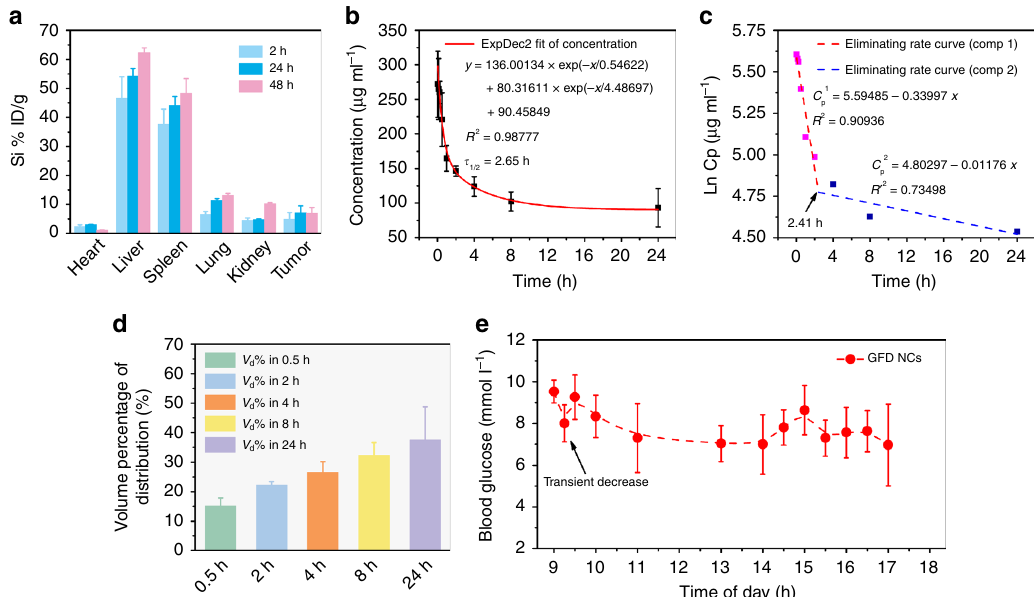
Fig. 6 Pharmacokinetics and pathoglycemia studies of GFD NCs. a The biodistribution of Si (% injected dose (ID) of Si per gram of tissues) in main tissues and tumor in 2, 24, and 48 h of intravenous administrations of GFD NCs ( n = 3). b The blood circulation curve of intravenously injected GFD NCs ( n = 5). The half-time ( τ 1/2 ) was calculated to be ~2.65 h. c The eliminating rate curve of intravenously injected GFD NCs from the blood circulation curve according to the ln(concentration) – T relationship. The two stage eliminating rates of GFD NCs can be seen. d The apparent volume percentage of distribution ( V d %) of intravenously injected GFD NCs ( n = 5). e Blood glucose level of mice in time of day. Mice ( n = 3) was intravenously injected of GFD NCs at 09:00. Mean values and error bars are de fi ned as mean and s.d., post injection. Their effective accumulation in tumor is a result of the EPR effect. In the blood-circulation experiment, a circulating half-life of 2.65 h in blood stream was obtained (Fig. 6b). The μ g ml − 1 per h in the second stage with a shifting time interval of 2.41 h (Fig. 6c). The apparent volume percentage of distribution